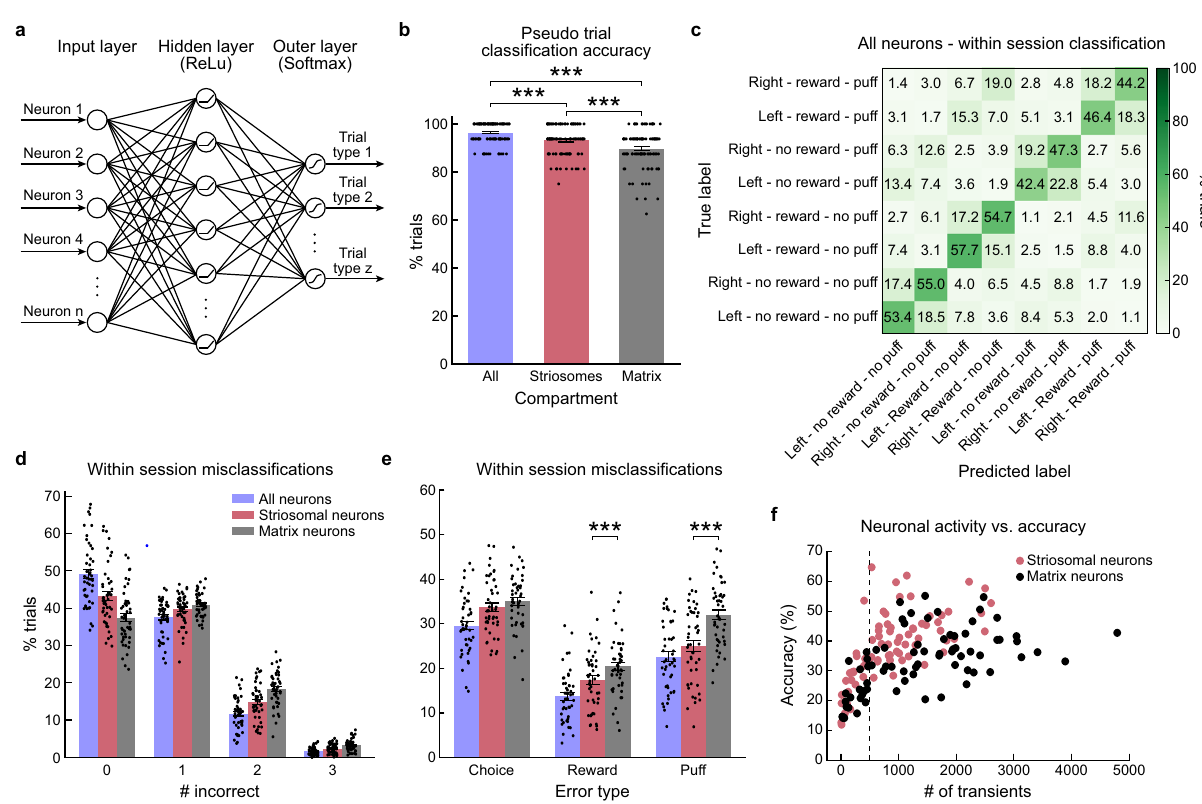
Fig. 6 Decoding analysis of action – outcome combinations. a Arti fi cial neural network architecture used for behavioral decoding. The hidden layer had the same size as the input layer. b Accuracy (mean ± SEM) of model using pseudo-trials for all SPNs ( n = 5831) and subsampled sSPNs ( n = 2249) or mSPNs ( n = 2249). The model including all SPNs had a higher accuracy than the compartment-speci fi c models (all vs. matrix: t = 7.30, p = 1e − 12; all